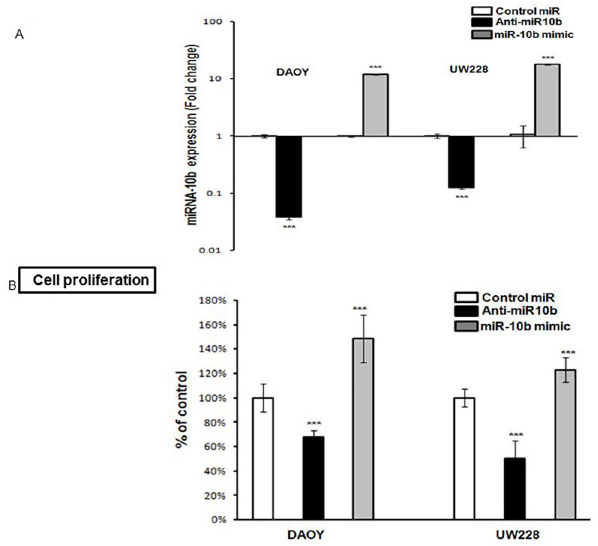
Fig 2. Inhibition of miRNA-10b inhibits cell proliferation and induces apoptosis. (A) Medulloblastoma cells were transfected with control miRNA, anti-miRNA-10b or miRNA-10b mimic. Total RNA was extracted after 48 hours of transfection and subjected to RT-PCR analysis for miRNA-10b expression. Error bars represent SD of the mean from at least 4 determinations. (B) Proliferation of transfected medulloblastoma cells with control miRNA, anti-miRNA-10b or miRNA-10b was analyzed by MTT proliferation assay measuring the intracellular NAD(P)H-oxidoreductase. (C) Percentage of apoptotic transfected cells was analyzed using a photometric cell death detection ELISA for identification of cytoplasmic histone-associated DNA fragments (n = 4). All results are represented as mean ± SD. (D) For the clonogenic growth assay, DAOY cells were transfected with miRNA-10b or inhibitor. After 24 hours, cells were seeded in 6-well plates (3000 cells/ well in triplicate). The plates were stained with the Hema 3 manual system after 12 to 14 days of incubation at 37°C. Left : representative photographs of the colonies; right : graphical representation of the colonies with over 50 cells (( ** P (cid:1) 0 . 05 and *** P (cid:1) 0 . 001 according to student ’ s